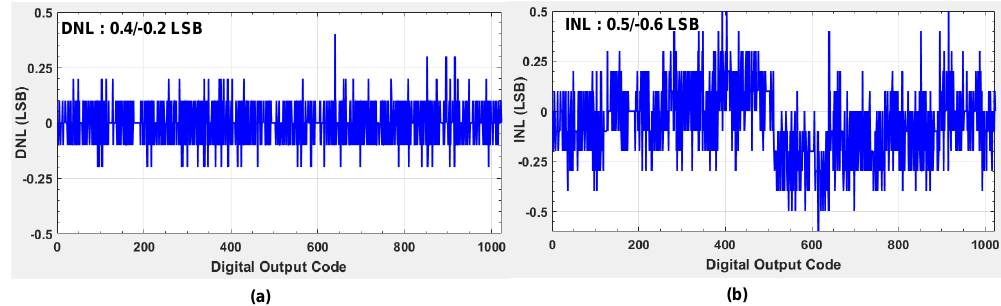
Figure 12. Measured Fast Fourier Transform (FFT) spectrum at sampling rate of 8 MS/s. ( a ) for 7.8125 kHz input frequency ( b ) for 2.0078125 MHz input frequency.